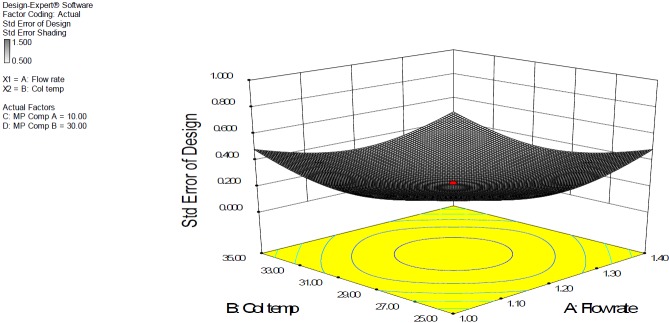
Three-dimensional plot of the full factorial for the predicted response resolution between the DAHHB and OCT peaks plotted on the y–axis as a function of factor A (flow rate) and B (column temperature); fixed factor: C (mobile phase A % tetrahydrofuran 10.0%) and D (mobile phase B % tetrahydrofuran 30.0%)